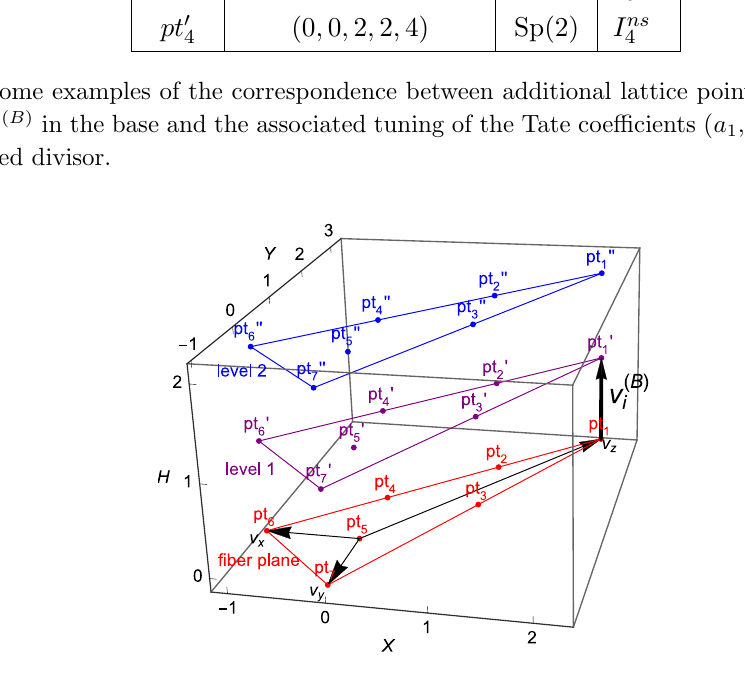
(in the direction H ) is a set of lattice points i